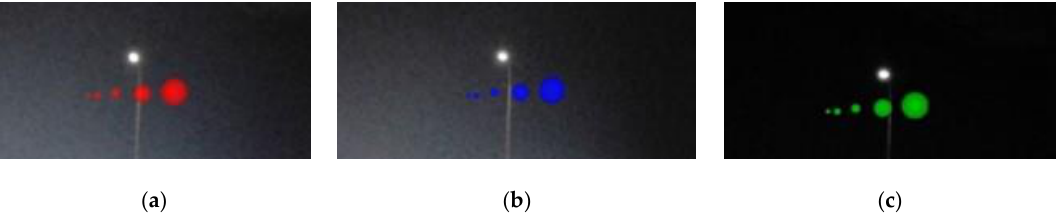
Figure 5. Matching spheres of different colors (size and luminosity) with the actual light at a distance of 150 m. ( a ) Red color spheres; ( b ) blue color spheres; ( c ) green color spheres.